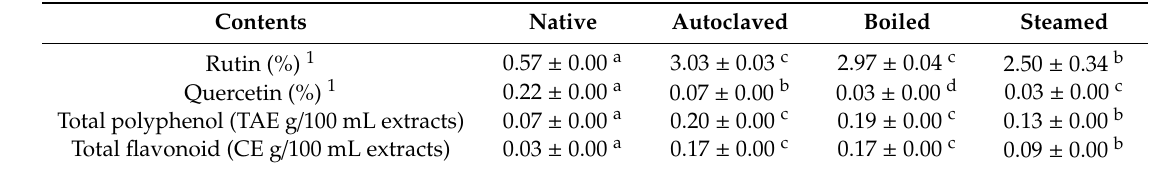
Table 1. The contents of rutin, quercetin, total polyphenols, and total flavonoids in native and rutin-enriched TBFEs. Di ff erent lowercase letters (a, b, c, and d) indicate significant di ff erences among native and rutin-enriched (autoclaved, boiled, and steamed) TBFEs ( p < 0.05).